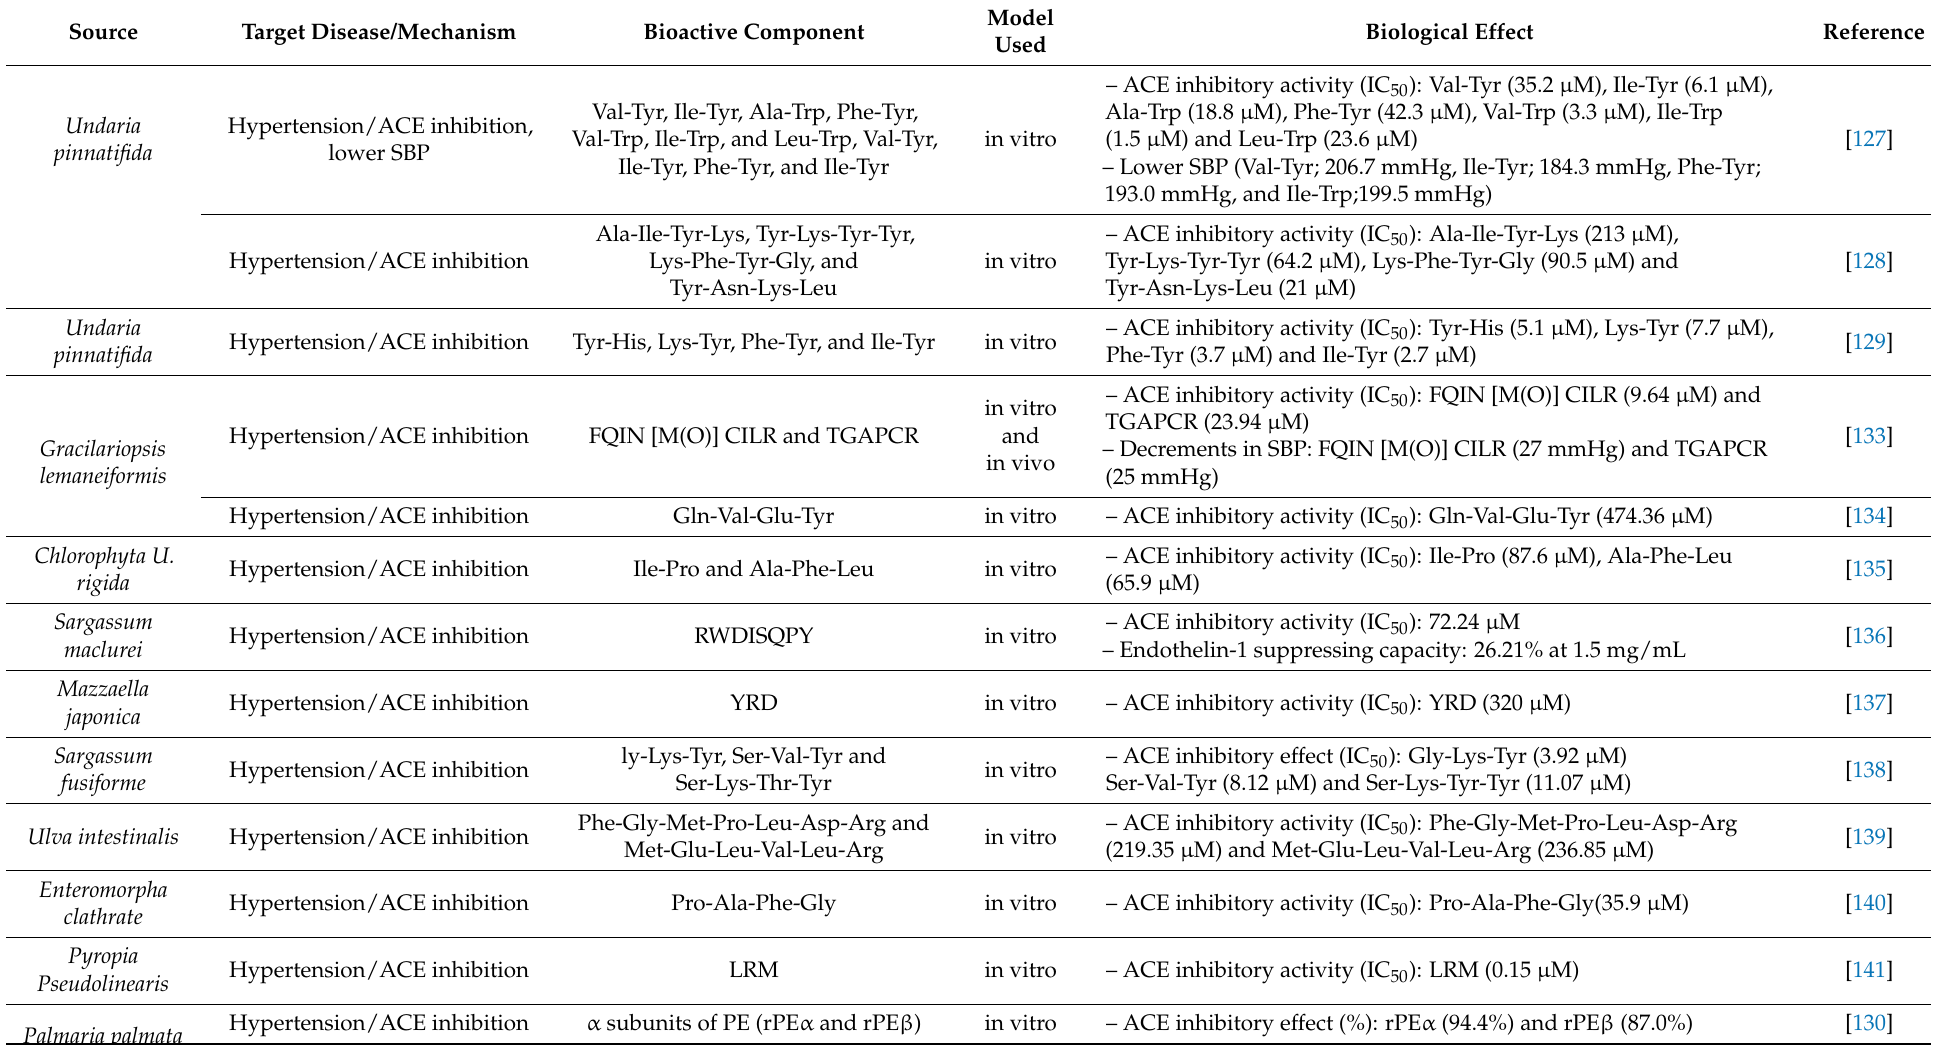
Table 3. Peptides isolated from seaweeds with therapeutic potential against cardiovascular